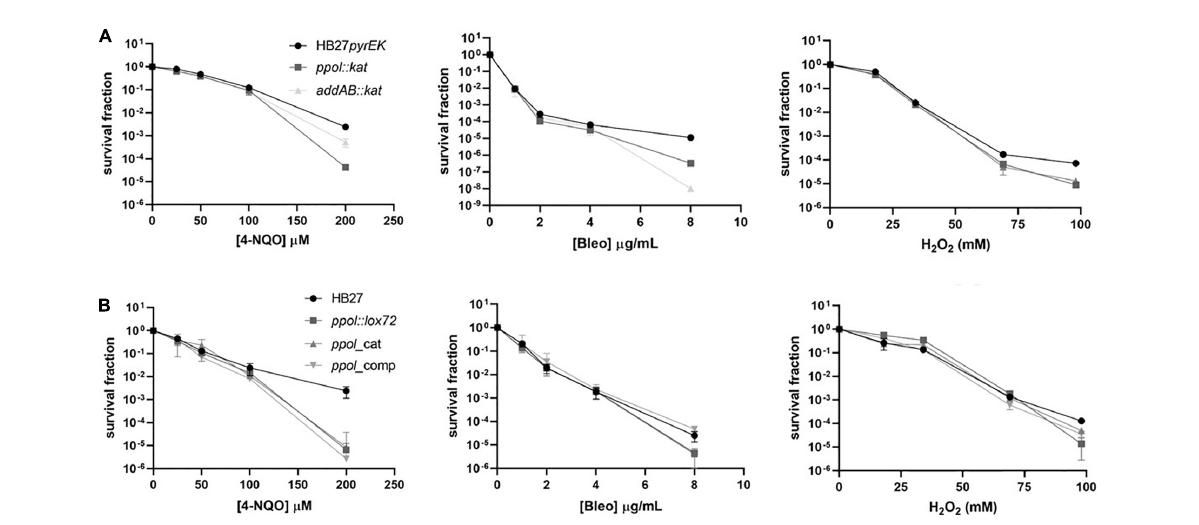
FIGURE3 Resistance to DNA damaging agents in the Thermus thermophilus mutants. (A) The HB27 pyrEK control strain and the ppol:kat and addAB:kat insertion mutants were subjected to different DNA damaging agents. The cell cultures were incubated at 65 ◦ C until OD 600 of 0.3 (3 × 10 8 cell/ml) was reached. Then, cells were further incubated for 2 h with the indicated concentrations of the different DNA damaging agents: peroxide hydrogen (H 2 O 2 ), 4-Nitroquinoline-N-oxide (4-NQO) and Bleomycin (Bleo). Then, 10 µ l of serial decimal dilutions were drop-inoculated on non-selective plates that were incubated at 65 ◦ C for 48 h. Fraction of surviving cells following DNA damage (4-NQO, left. Bleo, medium. H 2 O 2 , right) is calculated relative to an untreated control. (B) The HB27 control strain and its derivatives ppol:lox72, ppol_ cat , ppol_ comp, addAB:lox72 , and addAB_ppol mutants were subjected to the same DNA damaging agents used in panel (A) . Each data point is an average of at least five biological replicates. Error bars correspond to the standard deviation of the